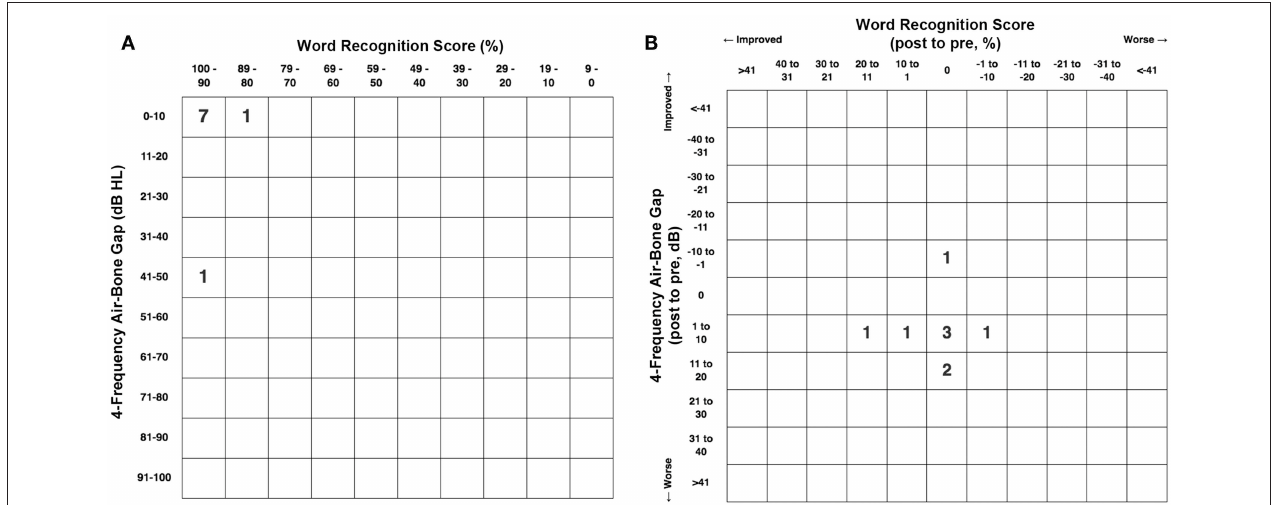
FIGURE 5 | (A) Pretreatment scattergram of audiometric data for the 8 patients (9 ears) who underwent round window reinforcement (RWR) for management of cochlea-facial nerve dehiscence (CFD) ( n = 8, Group 1) and CT negative (CT–) third window syndrome (TWS) ( n = 1). Seven of the 9 ears had a 4-frequency air-bone gap/pseudoconductive hearing loss between 2.5 and 8.75 dB (mean 5.63 dB). One subject ( Table 1 , Group 1 Patient 2) had a true conductive hearing loss with a pretreatment 4-frequency air-bone gap of 42.5 dB in his right ear; which had the CFD (see Figure 2 ). His other ear with the CT– TWS had a pretreatment air-bone gap of 6.25 dB and his pretreatment speech discrimination score was 88% on the left that improved to 100% post-treatment. Copyright © P.A. Wackym, used with permission. (B) Post-treatment scattergram of audiometric data for 9 patients who underwent round window reinforcement (RWR) for management of cochlea-facial nerve dehiscence (CFD) ( n = 8) and CT negative (CT–) third window syndrome (TWS) ( n = 1) in 8 subjects. Six ears had no change in word recognition score (WRS), including the 1 ear with a true conductive hearing loss and CFD (Patient 2). This same subject (Patient 2) had a CT– TWS ( Figure 2 ) on the left and had a pretreatment speech discrimination score of 88% that improved to 100% post-treatment. Excluding the ear of Patient 2 with the true conductive hearing loss, the pseudoconductive hearing loss with the added conductive hearing loss as a result of the RWR procedure had a mean 4-frequency air-bone gap of 10.94 dB (range 5–23.75 dB). As shown in the scatterplot, 8 ears had worsening of the air-bone gap; while only Patient 5 had an improvement from 7.5 to 5 dB for the 4-frequency air-bone gap. This likely represents the test-retest variability. There was no statistically significant difference in the 4-frequency air-bone gap pretreatment compared to post-treatment ( p = 0.091). Copyright © P.A. Wackym, used with